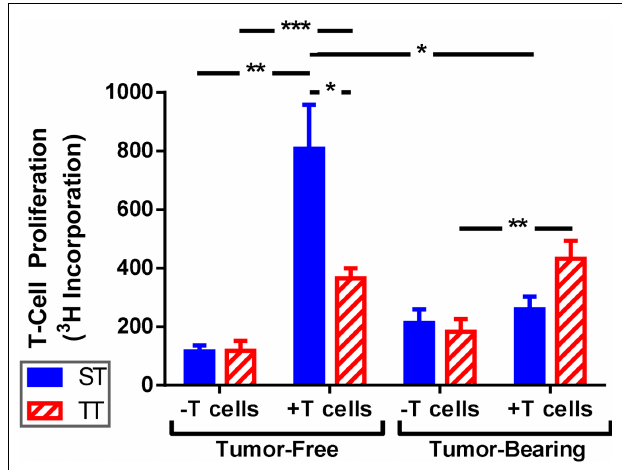
FIGURE 5 |T cells are activated better by splenocytes from mice atTT than ST .Total splenocytes from tumor-free and tumor-bearing BALB/c mice and lymphocytes from C57BL/6 mice were cultured 1:2.T cell proliferation was measured by 3 H-thymidine incorporation. Data presented as mean ± SEM; n = 5/group; Student’s t -test; * p < 0.05, ** p < 0.01, *** p <